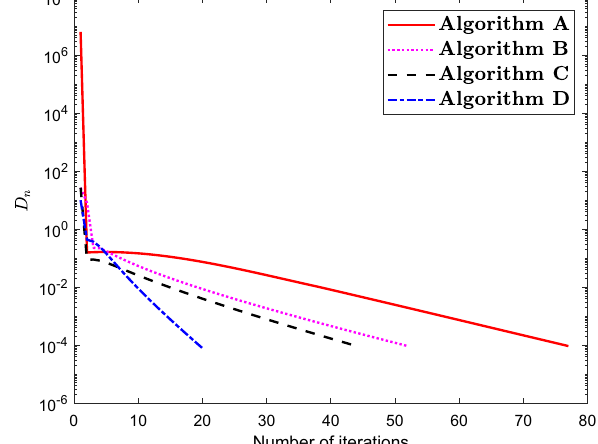
Fig. 6 Numerical illustration of Algorithm 1 with Algorithm 1 in [16] and Algorithm 3.1 in [1] and Algorithm 3.1 in [27] while u 0 = u 1 = ( 1 , 1 ,..., 1 5000 , 0 , 0 ,...)